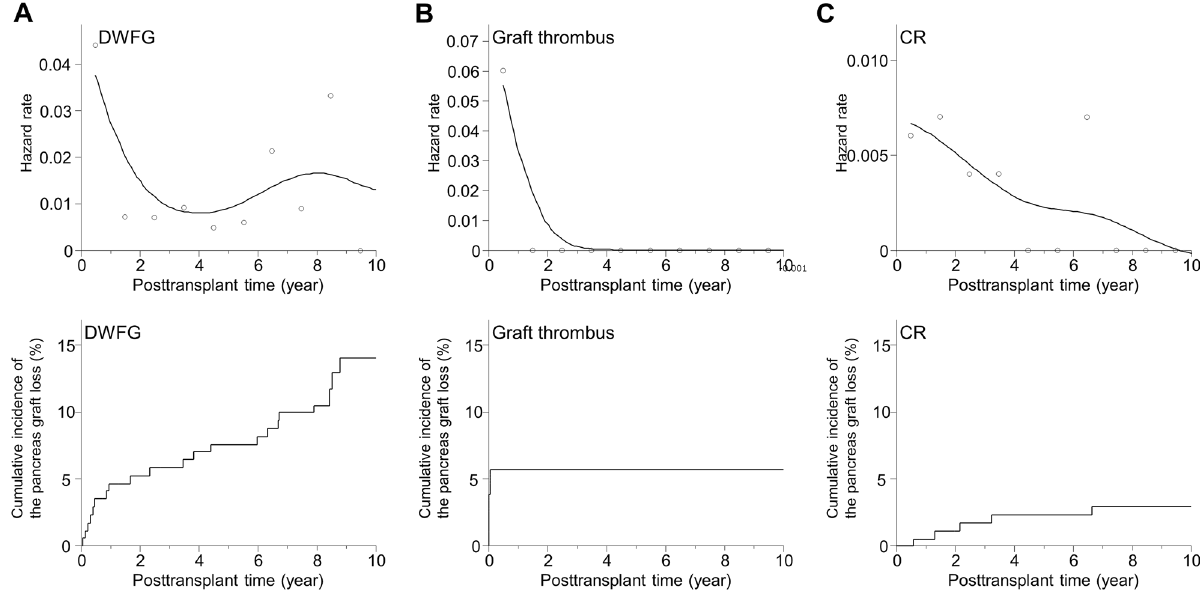
Figure 1. Hazard rates and cumulative incidences of specific causes of pancreas graft loss in SPK cases. Upper panels: Hazard rates for graft loss within 10 years due to ( A ) DWFG, ( B ) graft thrombus, and ( C ) CR. Solid lines show smoothed curves obtained with a Kernel smoothing procedure based on the causes of the pancreas graft loss. The hazard rates were measured in terms of the number of events per the number of patients at risk over a 1-year interval. The smoothed curves were created to visualize the pattern of the hazard rates with a Kernel smoothing procedure. Lower panels: Cumulative incidences of post-transplant pancreas graft loss due to ( A ) DWFG, ( B ) graft thrombus, and ( C ) CR (solid lines). The cumulative incidence was assessed by the Kaplan– Meier method. CR chronic rejection, DWFG death with a functioning graft, SPK simultaneous pancreas-kidney